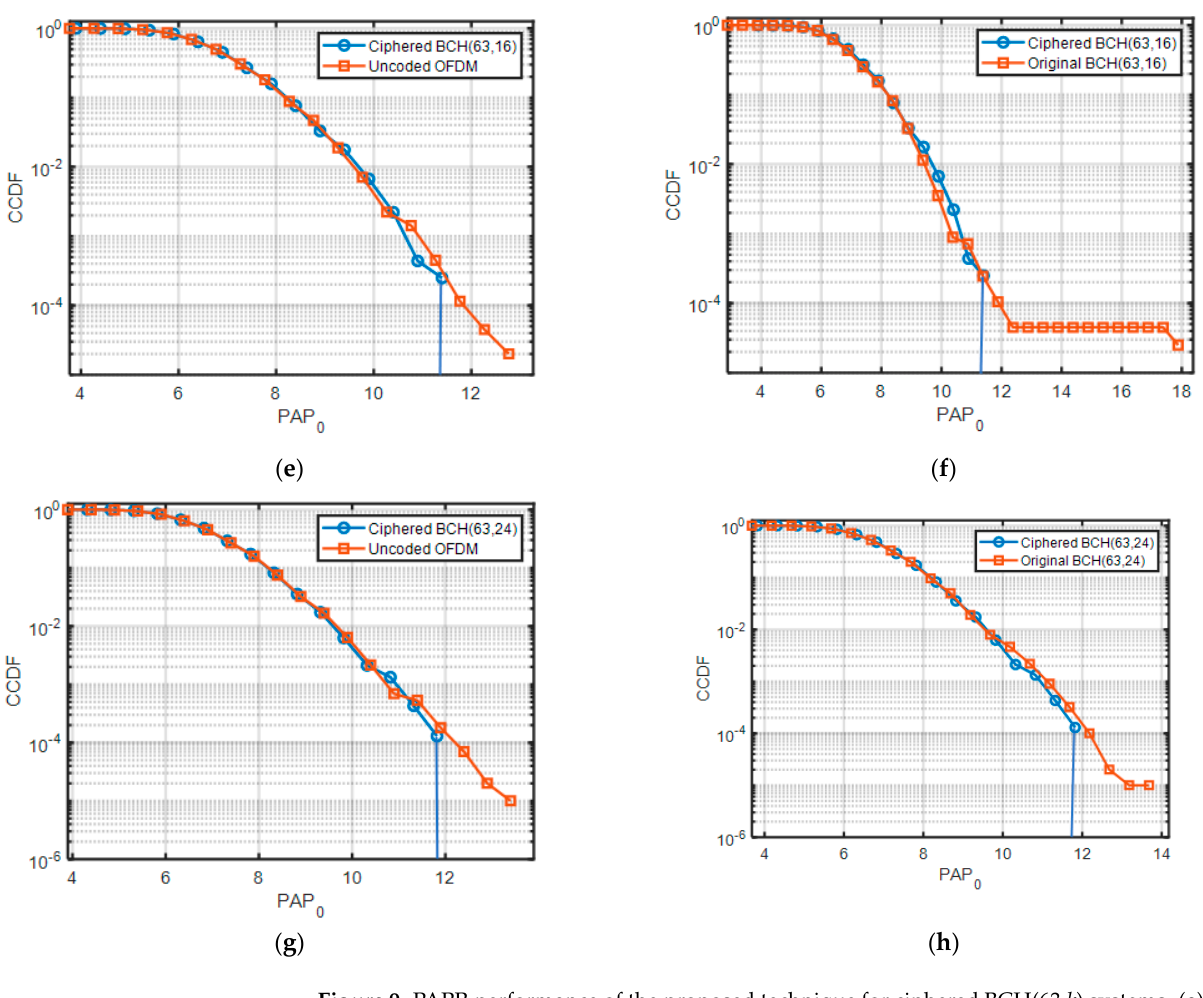
Figure 9. PAPR performance of the proposed technique for ciphered BCH(63, k ) systems. ( a ) Ciphered BCH(63,7) vs uncoded OFDM, ( b ) Ciphered BCH(63,7) vs original BCH(63,7), ( c ) Ciphered BCH(63,10) vs uncoded OFDM, ( d ) Ciphered BCH(63,10) vs original BCH(63,10), ( e ) Ciphered BCH(63,16) vs uncoded, ( f ) Ciphered BCH(63,16) vs original BCH(63,16), ( g ) Ciphered BCH(63,24) vs uncodedand ( h ) Ciphered BCH(63,24) vs original BCH(63,24).